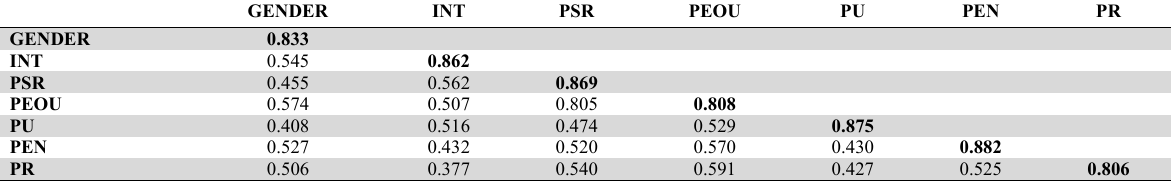
Fornell-Larcker Scale